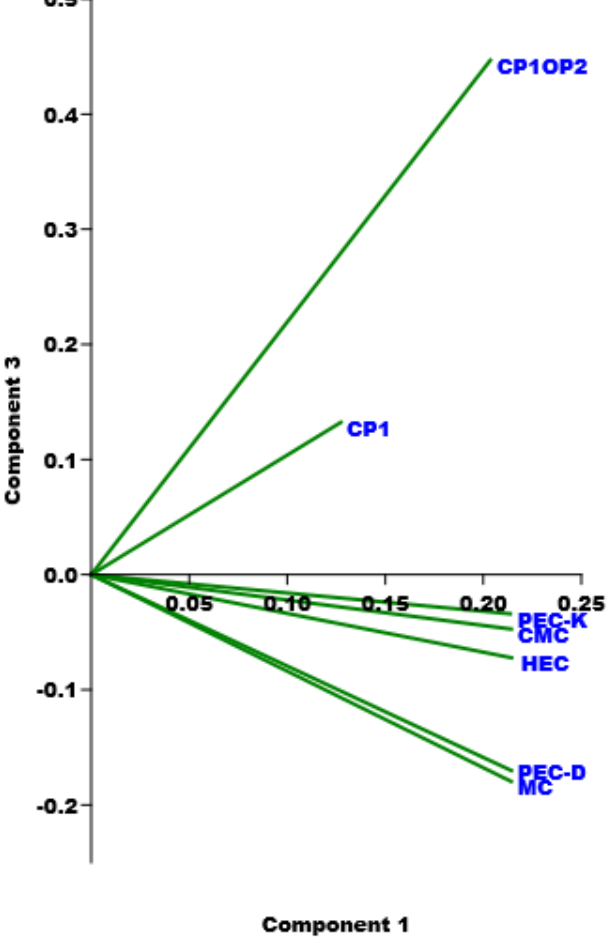
Figure 14. PC1 vs. PC3 by PCA experiments.